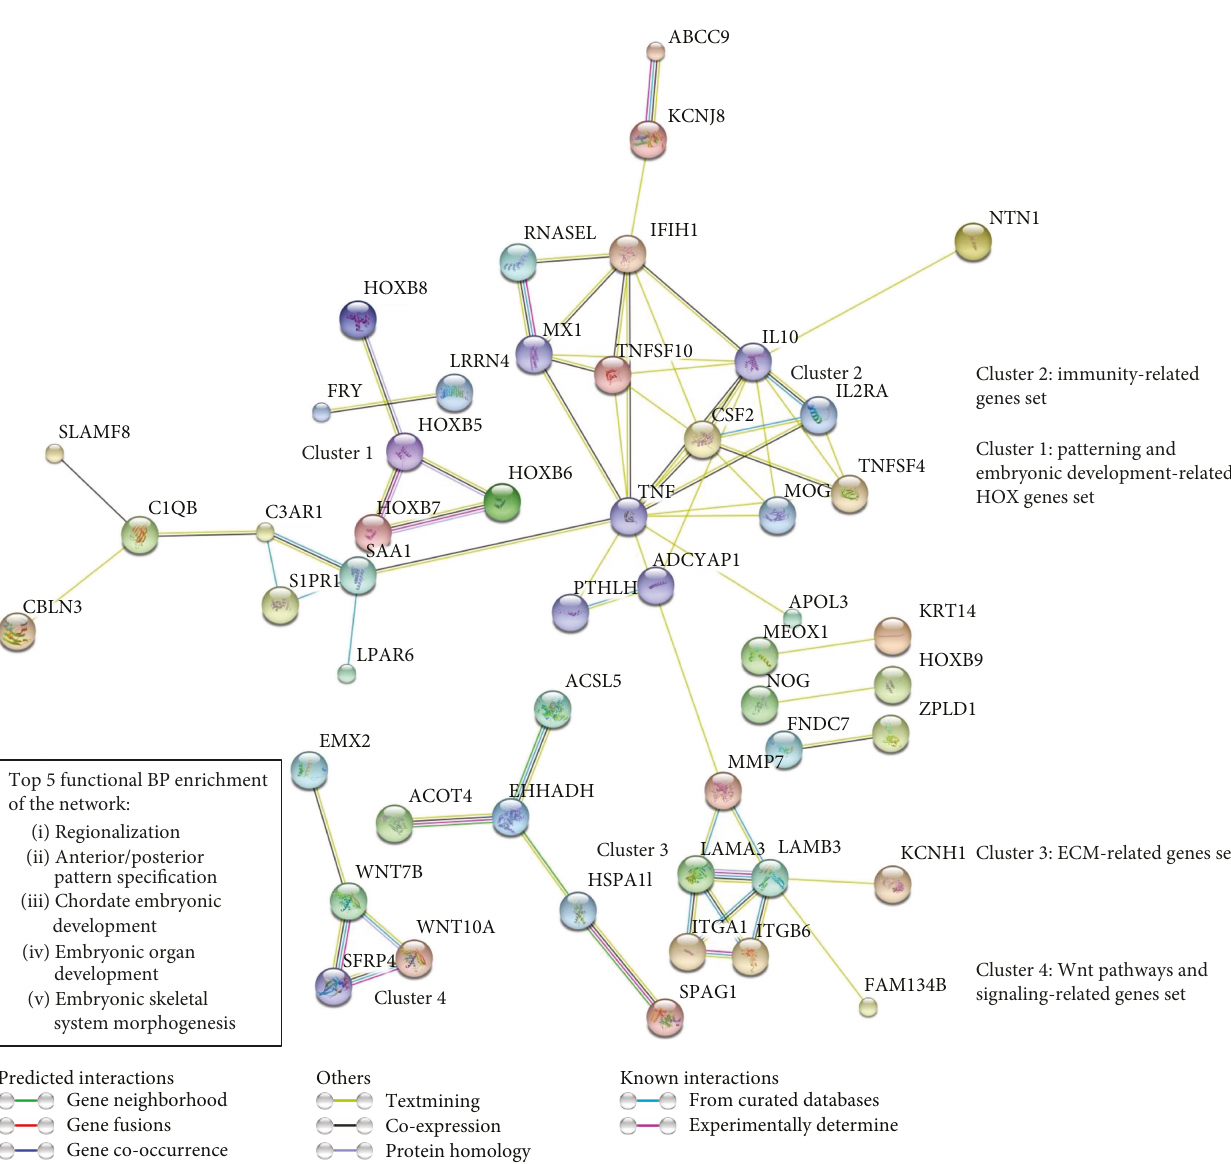
Figure 7: Network analysis of the 181 AF-MSC-speci fi c genes. STRING network analysis revealed 4 distinct clusters: cluster 1 represents the genes involved in patterning and embryonic development which mainly involves the HOX genes. Cluster 2 contains genes related to immunity (e.g., TNF and IL-10). Extracellular matrix- (ECM-) related genes are found in cluster 3, and cluster 4 shows genes related to WNT